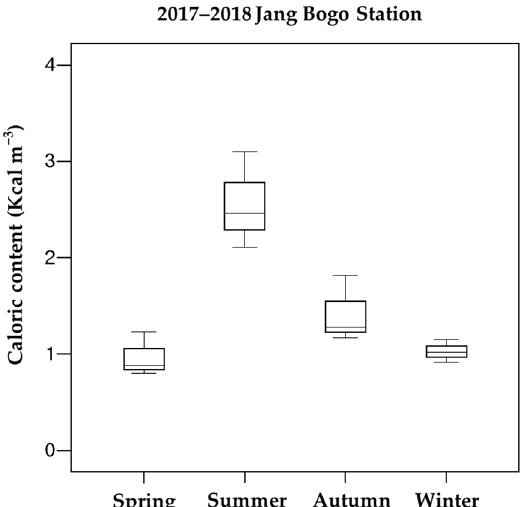
Figure 8. Seasonal variations in the caloric content of FM at the JBS during our sampling period.